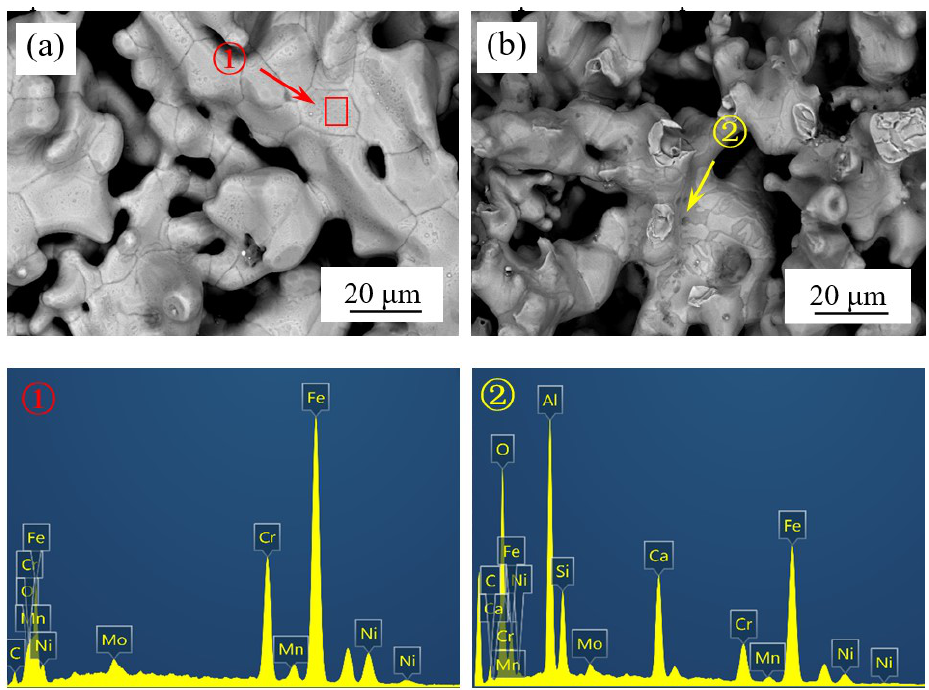
Figure 18. Back-scattered electronic image of porous 316 stainless steel with stronger magnetic separation iron oxide scale; ( a ) surface; ( b ) inside; ① the energy spectrum analysis of point ① ; and ② the energy spectrum analysis of point ① .